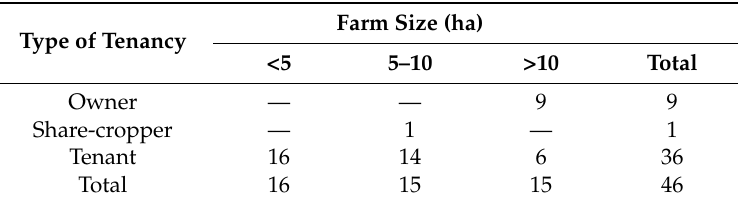
Table 2. The revised survey population, stratified according to the actual types of tenancy and farm sizes determined by the survey. Farm Size (ha) Type of Tenancy <5 5–10 >10 Total 9